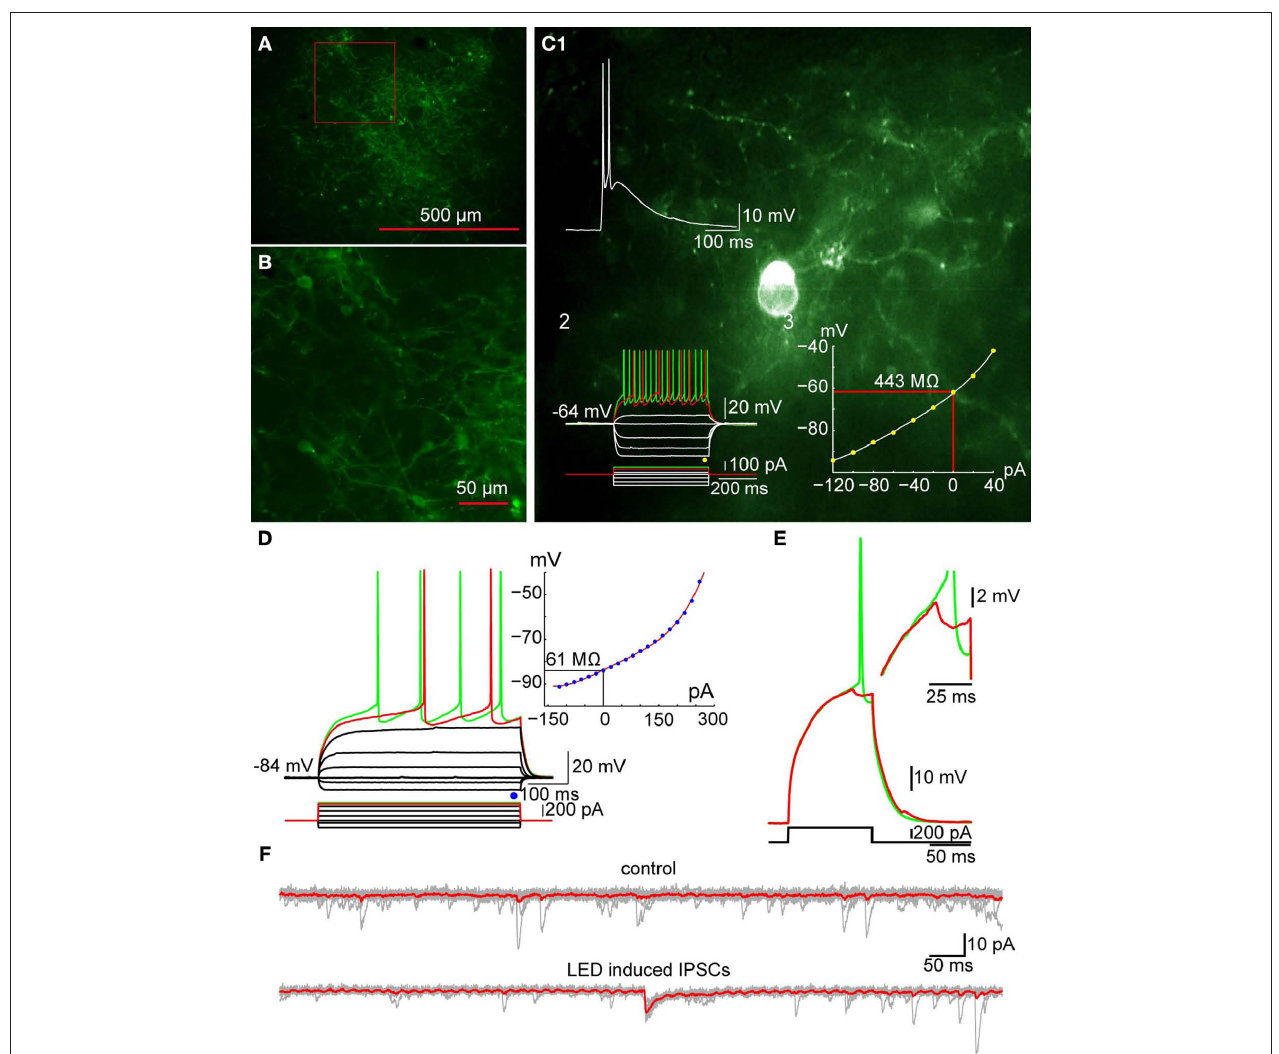
FiGurE 8 | Optogenetic activation of TH + interneurons inhibits SPN firing. (A) Photomicrograph of a parasagittal slice obtained from a TH-Cre mouse injected with AAV-2:EF1:DOI:CHR2-EGFP. Note the large area of infection ( ∼ 1 mm, in diameter). (B) Higher magnification of the area indicated by the red rectangle in A showing numerous AAV-infected TH + interneurons as well as axonal and dendritic processes expressing ChR2-YFP (green). (C) Photomicrograph of a single ChR2 expressing striatal TH interneuron recorded in current clamp. C1: A 2-ms pulse of blue light elicits action potentials in the TH + interneuron. C2: Responses to